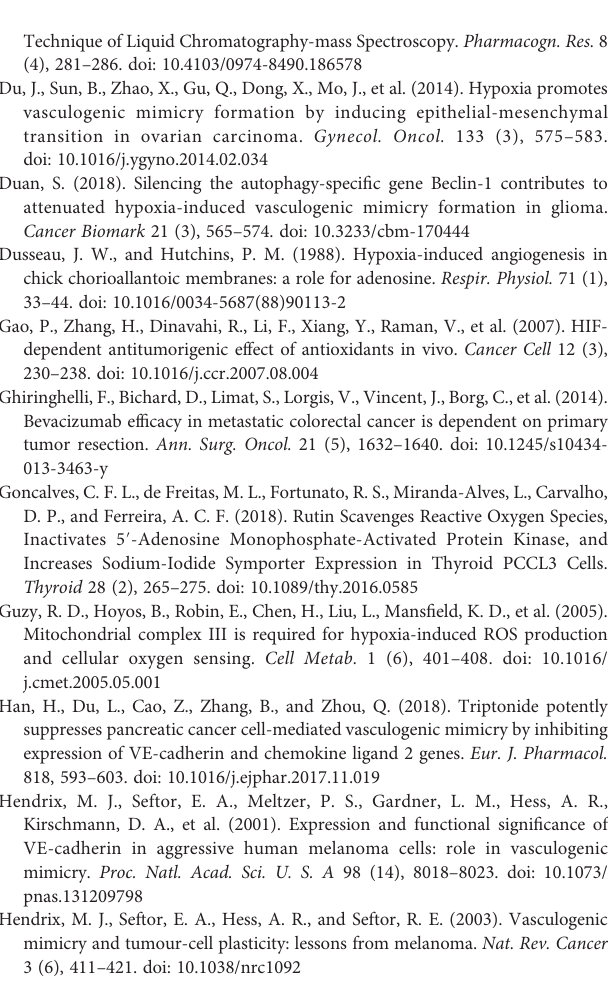
FIGURE S1 | Identi fi cation of highly metastatic colorectal cancer cells that could form VM. Highly metastatic CRC cells (DLD-1, SW620, HCT-116 and LoVo cells) were seed into 96 well plate which had been pre-coated with Matrigel for 24 hours. The representative images were shown in magni fi cation of DLD-1, SW620, HCT- 116 and LoVo cells (50×). FIGURE S2 | Hypoxia accelerates migration and requires ROS generation. Wound-healing assays of HCT-116 and LoVo cells. The cells were treated with medium alone, NAC (10mmol/L), hypoxia medium, hypoxia medium with NAC (10mmol/L) for 24 h. The representative images were shown in magni fi cation of 100× (A, B); (C and D) the relative scratch area was measured by Image J (* P <